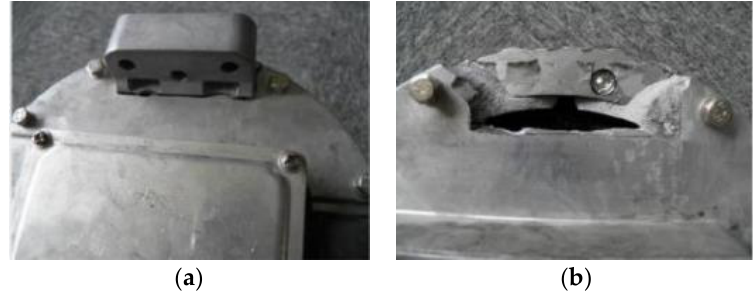
Figure 1. Power train shell crack. ( a ) Before cracking; ( b ) after cracking.